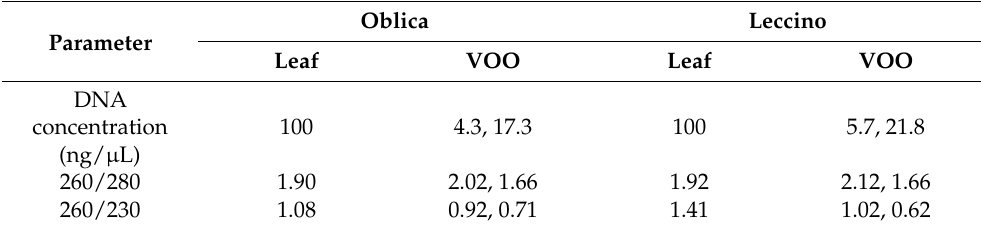
Table 6. Concentration and purity of isolated DNA from leaves of Oblica and Leccino cultivars and the corresponding monocultivar virgin olive oils.